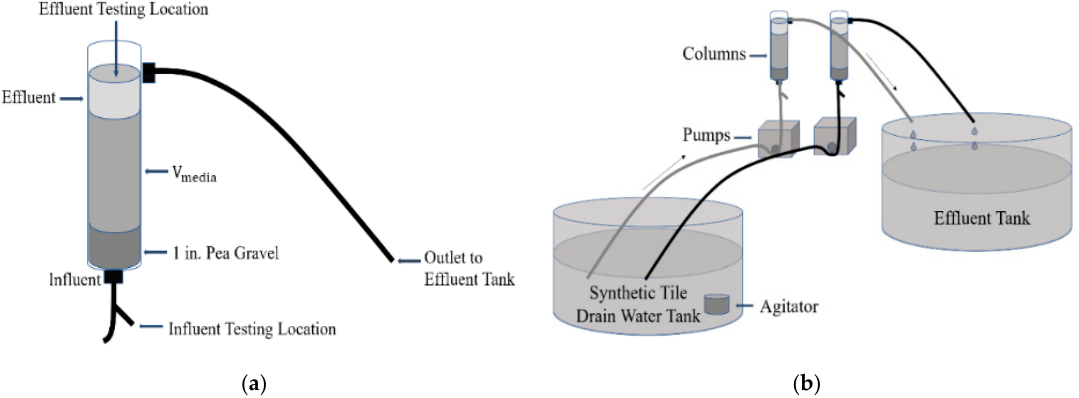
Figure 1. ( a ) Laboratory column and ( b ) diagram of phosphorus sorbing media (PSM) columns connected to the influent and effluent tanks.